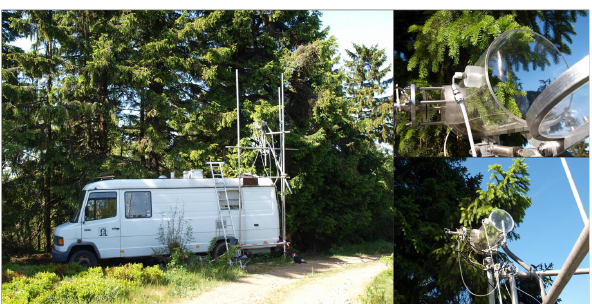
Fig. 1. Cuvette setup in the field on Kleiner Feldberg, Taunus, Ger- many: the enclosure system was fixed at a Norway spruce branch. The instruments (Sensors, PTR-MS, CRM) were located in the van underneath to keep inlet lines short. For 17min the lid was kept open to allow contact with the natural atmospheric environment and closed automatically for